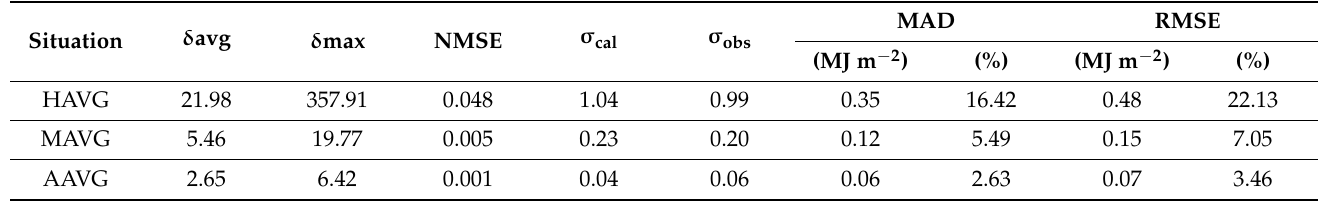
Table 3. Same as Table 2, but for the statistical metrics during 2007–2020, using empirical model of global solar radiation (n =